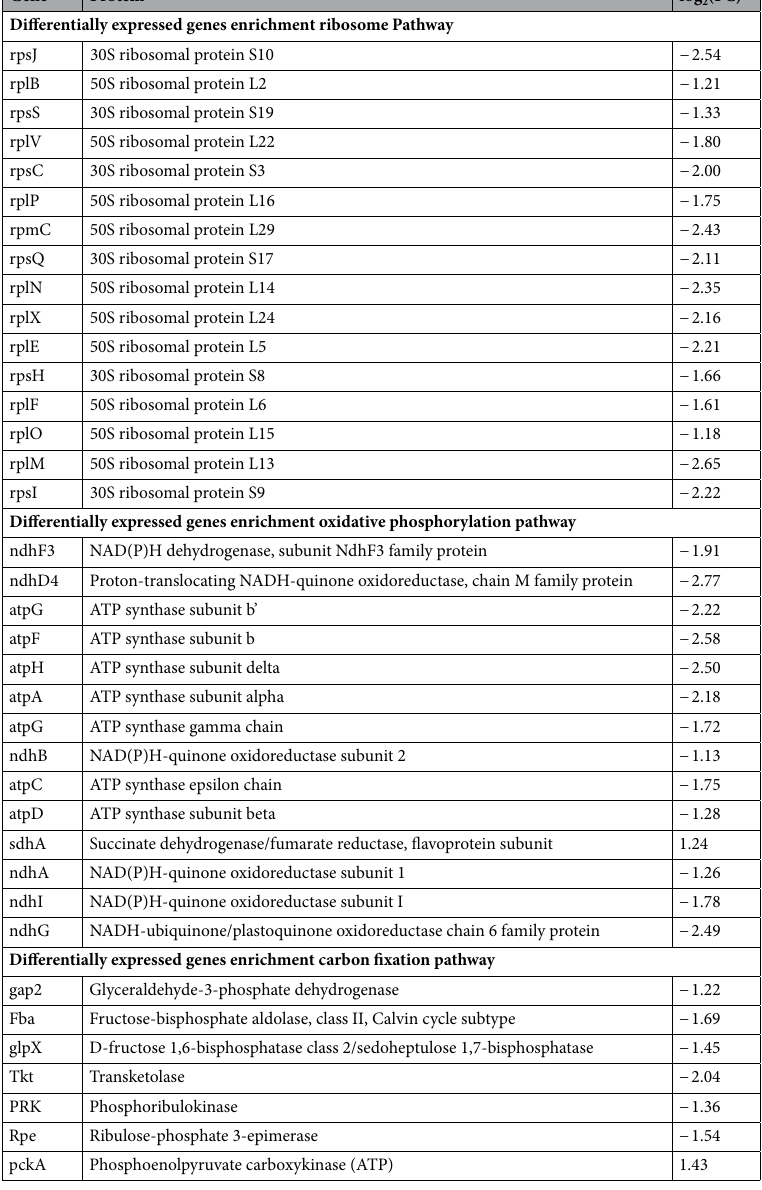
Table 2. Differentially expressed genes enrichment Pathway. Log 2 (FC) represents the logarithm of genes with a fold change between E and C, with 2 as the base. If FDR < 0.05 and | log 2 FC |> 1, the difference is significant. All genes in this table FDR < 0.05.